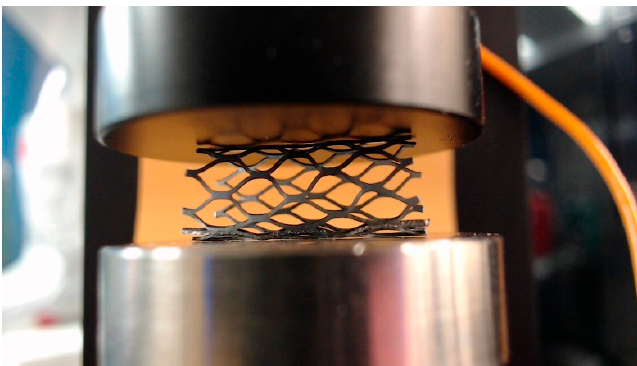
Figure 4. Mechanical/crash test of photo-chemically etched cylindrical rhombus stents. N The maximum resistive force exerted (N) Radial force (cid:3436) mm(cid:3440) =